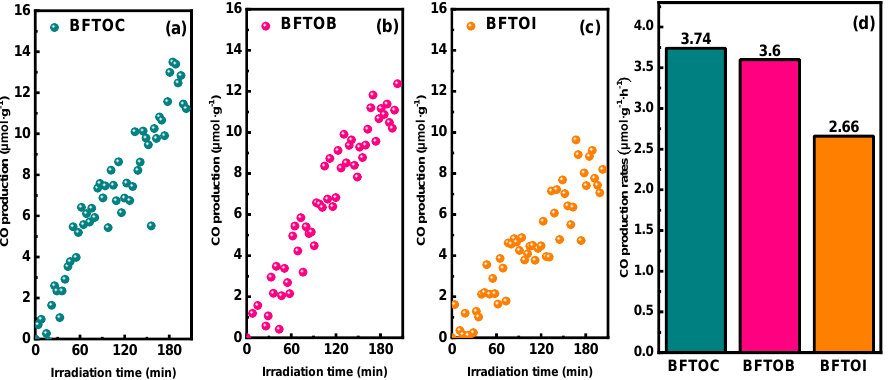
Figure 4. CO production of ( a ) BFTOC, ( b ) BFTOB, and ( c ) BFTOI, respectively. ( d ) The average CO production rates of BFTOX (X = Cl, Br, and I).